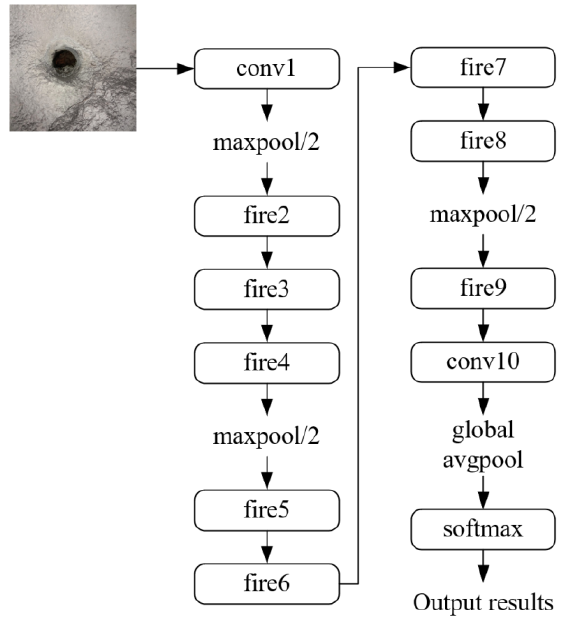
Figure 4. Structure of the SqueezeNet model.